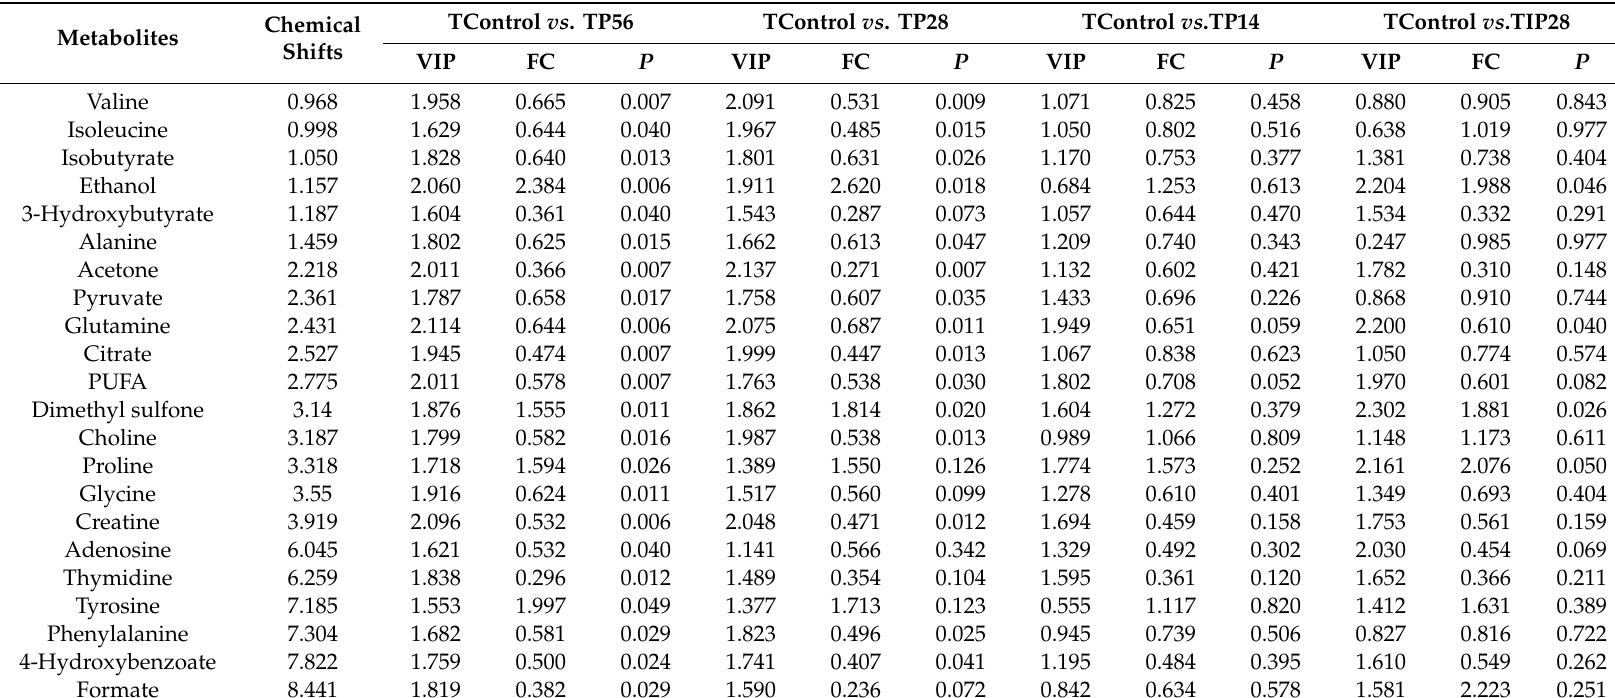
Table 5. The VIP, fold change and P values of 22 di ff erential metabolites in drug treatment